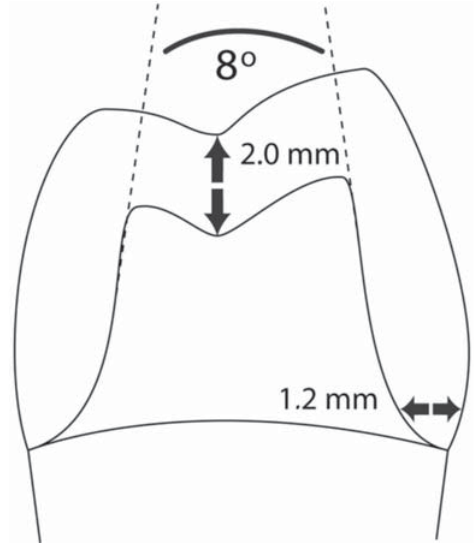
Figure 1- Schematic representation of the prepared tooth and